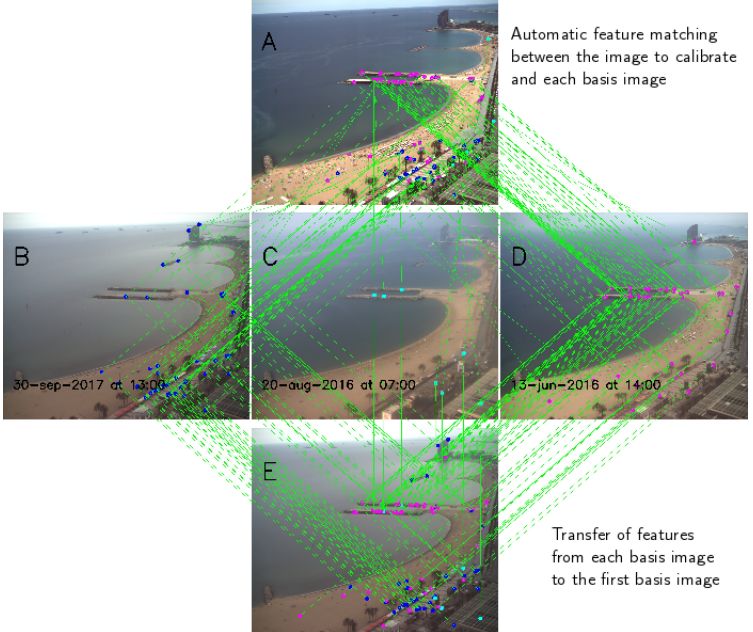
Figure 4. Illustration of the step 2. Image to calibrate ( A ), basis of images ( B – D ) and the first image of the basis, including all the pairs found ( E